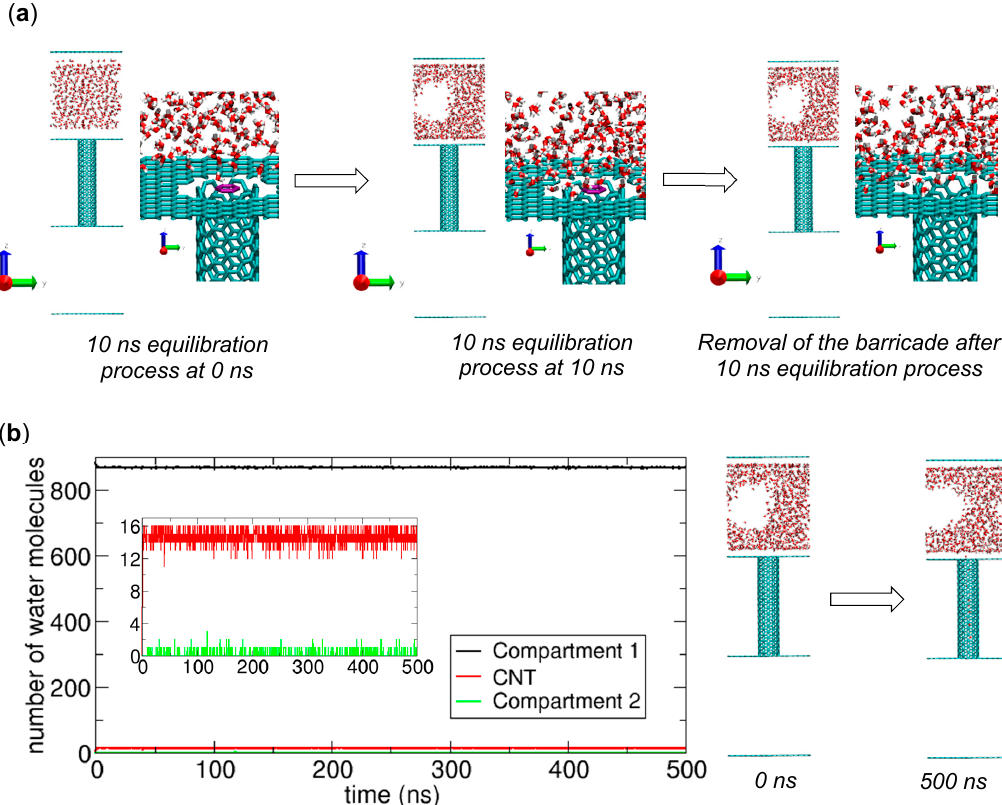
Figure 2. Simulation of water molecule transport from a filled compartment (Compartment 1) to another empty compartment (Compartment 2) through a carbon nanotube (CNT) in the absence of osmolytes. ( a ) Configurations at 0 ns (left) and 10 ns (center) from a 10 ns equilibration process in the presence of a molecular barricade (violet) at the boundary between Compartment 1 and the CNT, and the configuration (right) in which the barricade has been removed, after the equilibration process. The last configuration is used for the simulation of water molecule transport in the next process. ( b ) Results of water transport simulation. Changes in the numbers of water molecules in Compartment 1 (black), the CNT (red), and Compartment 2 (green) during a 500 ns NVT simulation (left) along with snapshots at 0 and 500 ns (right). The inset shows a zoomed-in view of the changes in the CNT and Compartment 2.